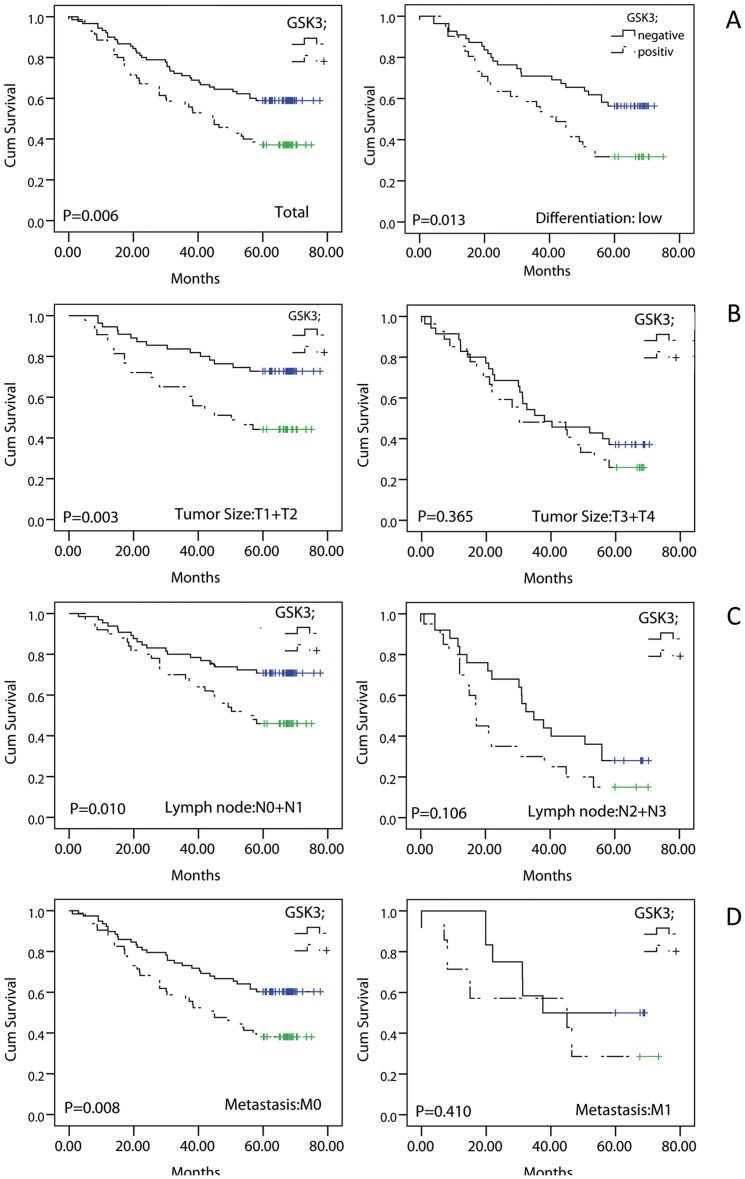
Positive expression of GSK3β is associated with poor prognosis for NSCLC.(A) In the entire group, patients with positive GSK3β expression had shorter survival times, P = 0.006. Figure 2B-D shows the survival analysis for the subgroups. (B) In the lower differentiation subgroup, patients with positive GSK3β expression had significantly shorter survival times, P = 0.013. (C) In the T1+T2 subgroup, patients with positive GSK3β expression had significantly shorter survival times, P = 0.003. (D) In the N0+N1 subgroup, patients with positive GSK3β expression had significantly shorter survival times, P = 0.010. (E) Patients in the M0 subgroup with positive GSK3β expression had significantly shorter survival times, P = 0.008. Kaplan-Meier curves for the investigated proteins were used to compare the positive (dashed lines) and negative phenotypes (solid lines).